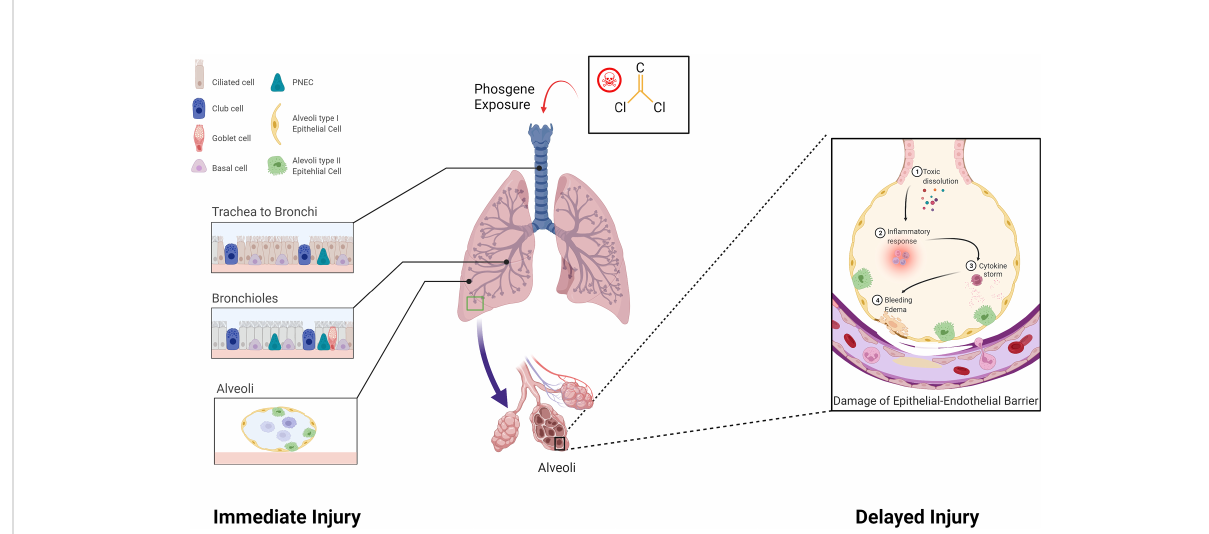
FIGURE 1 Pathological processes involved in phosgene-induced acute lung injury. Two pathological processes are involved: Immediate injury: Phosgene exposure damages the lungs, leading to necrosis of club cells and ciliated epithelial cells that cover the trachea, bronchus, and alveoli. Delayed injury: Uncontrolled in fl ammatory responses result in a cytokine storm, which leads to a cascade-like in fl ammatory reaction, secondary biological attack, and further aggravation of the epithelial-endothelial barrier (created with